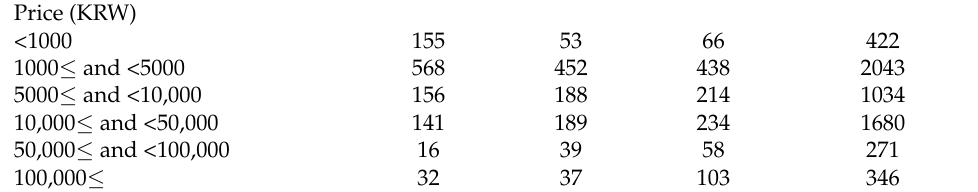
Panel A suggests that the introductions of dynamic and static VIs seem to cause no significant changes in firm characteristics. Our results show that small, illiquid, and volatile firms tend to experience dynamic VI, whereas small and volatile but more liquid firms appear to experience static VI more frequently. In untabulated results, static VI occurrences are positively correlated with liquidity variables, while dynamic VI occurrences are negatively correlated. The negative relation of dynamic VI occurrences with